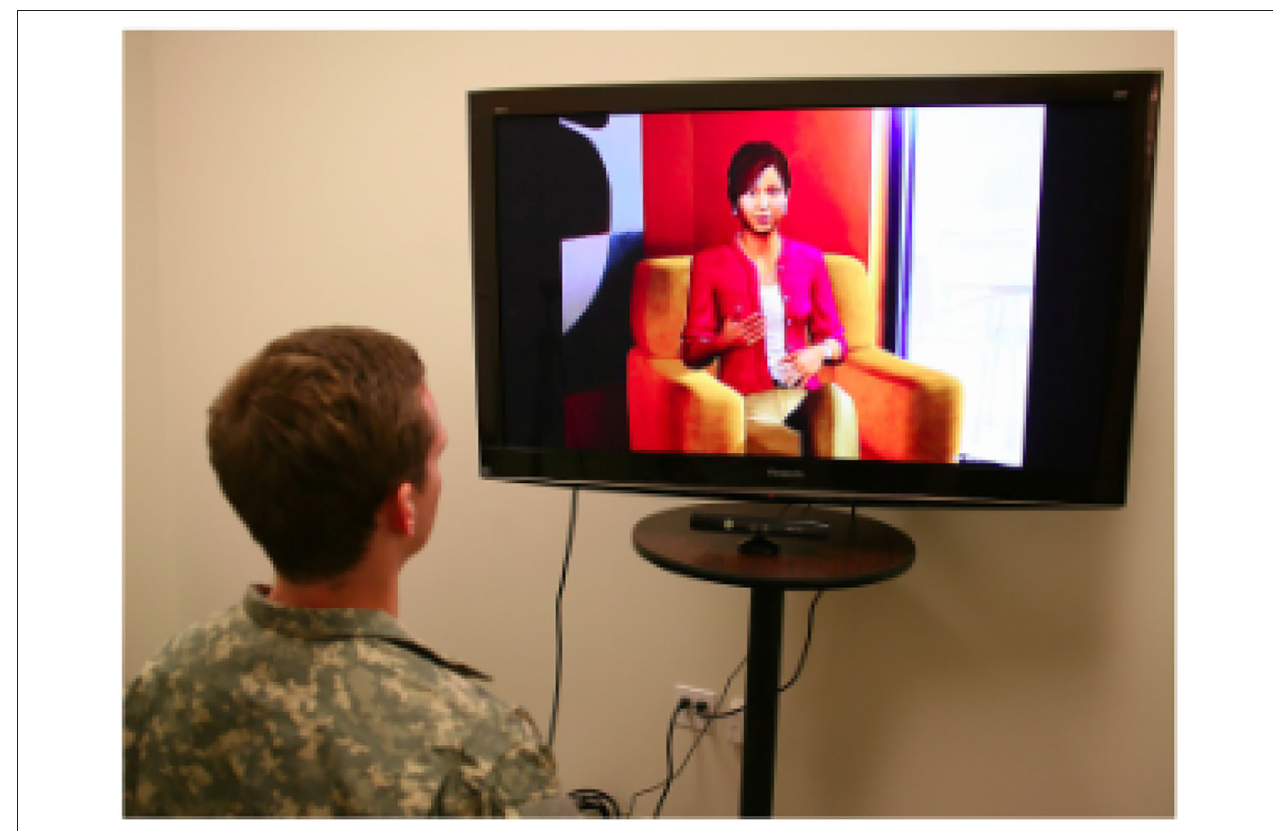
FIGURE 1 | Interview process with Ellie. Participants were placed in a room in front of a large computer screen, showing the animated character Ellie in the Wizard-of-Oz